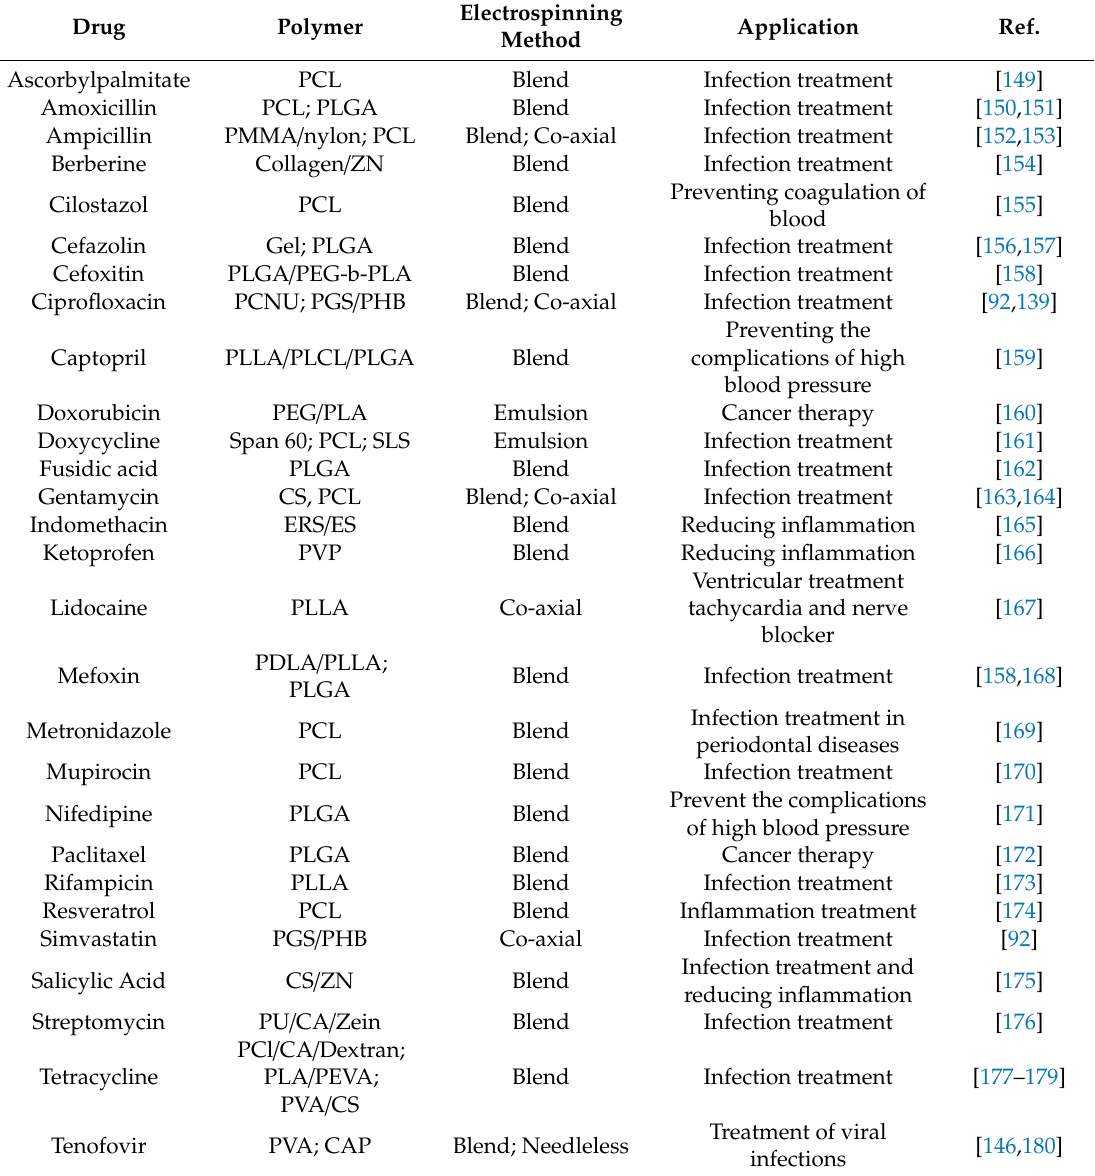
Table 3. Summary of the drug delivery of di ff erent drugs and their biomedical